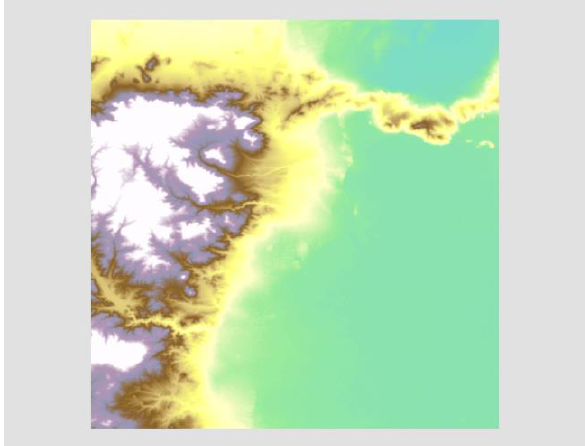
Figure 8. DEM of Sentinel-1A image (Test Area Subset)